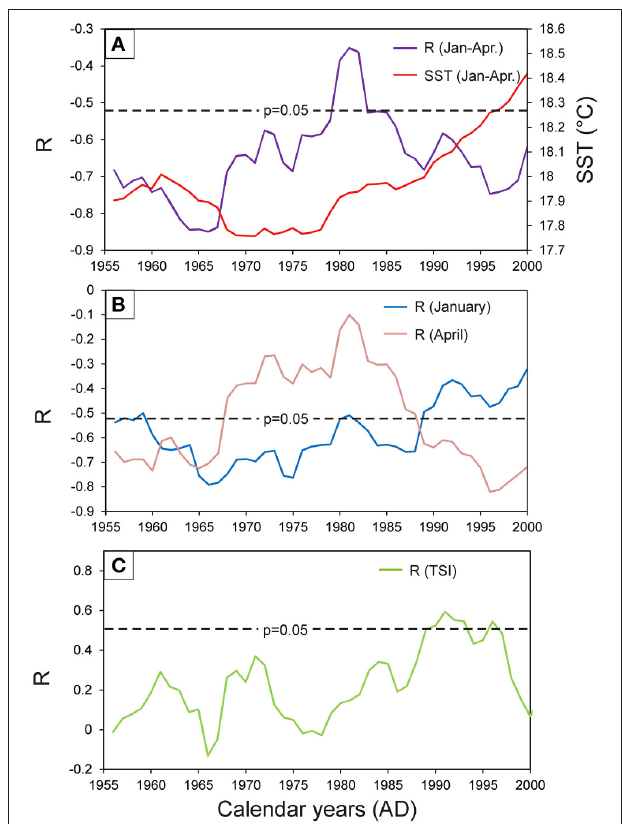
FIGURE 6 | Temporal changes in the correlation patterns between the monthly sea surface temperature of the Madeira region (HadISST, 17W − 16W; 33N − 32N) and the robust section (1950–2012) of the Madeiran G. vangentsumi Hugershoff-detrended arstan chronology. Dashed lines corresponds to the p = 0.05 significance levels. (A) Correlation of the monthly averaged January–April sea surface temperature and the composite chronology (purple) calculated in 15-year running windows compared to the inter-annual fluctuations of the 15-year running mean of January–April sea surface temperature (red). (B) Coefficients of the 15-year running correlation calculated between the January sea surface temperature and the composite chronology (blue) compared to the 15-year running correlation coefficients calculated between April sea surface temperature and the composite chronology (pink). (C) Correlation calculated in 15-year running windows between the annual mean total solar irradiance and the composite